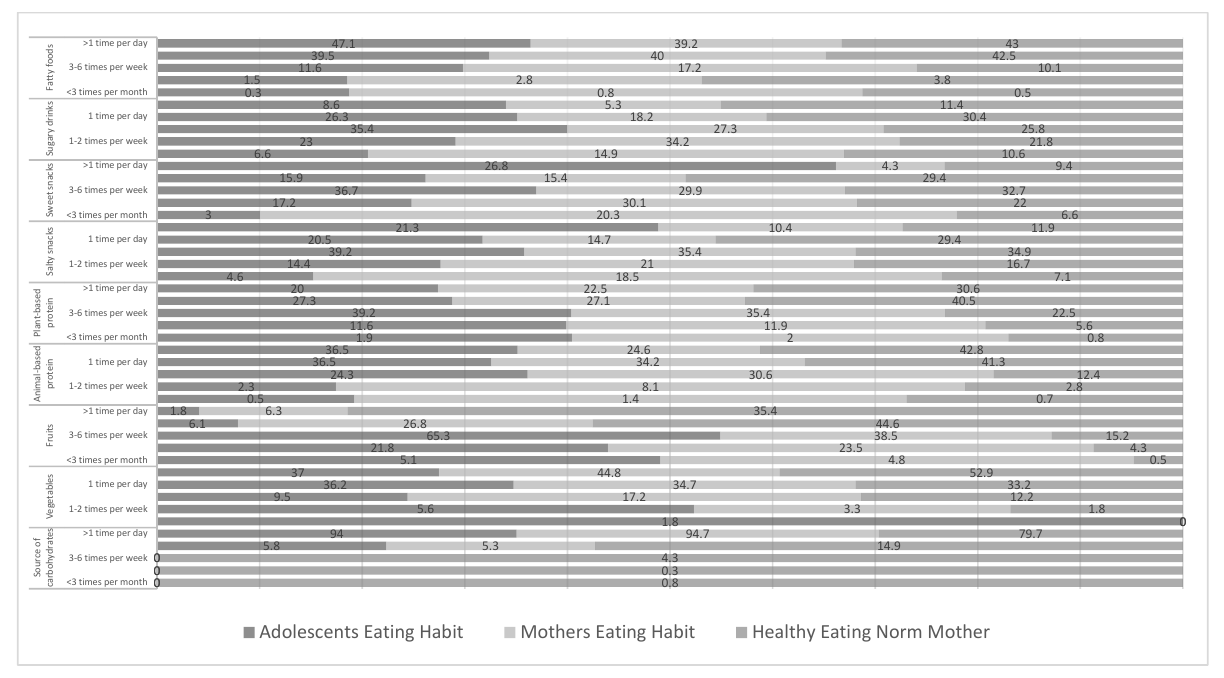
Figure 1. Adolescents’ eating habits, mothers’ eating habits, and mothers’ healthy eating norms. Table 2. Correlation between adolescents’ eating habits, mothers’ eating habits, and mothers’ healthy eating norms.